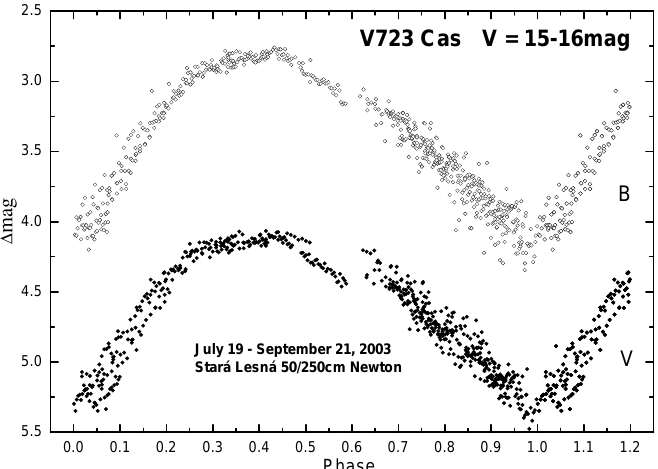
Fig. 2. The new CCD BV phase light curve of V723